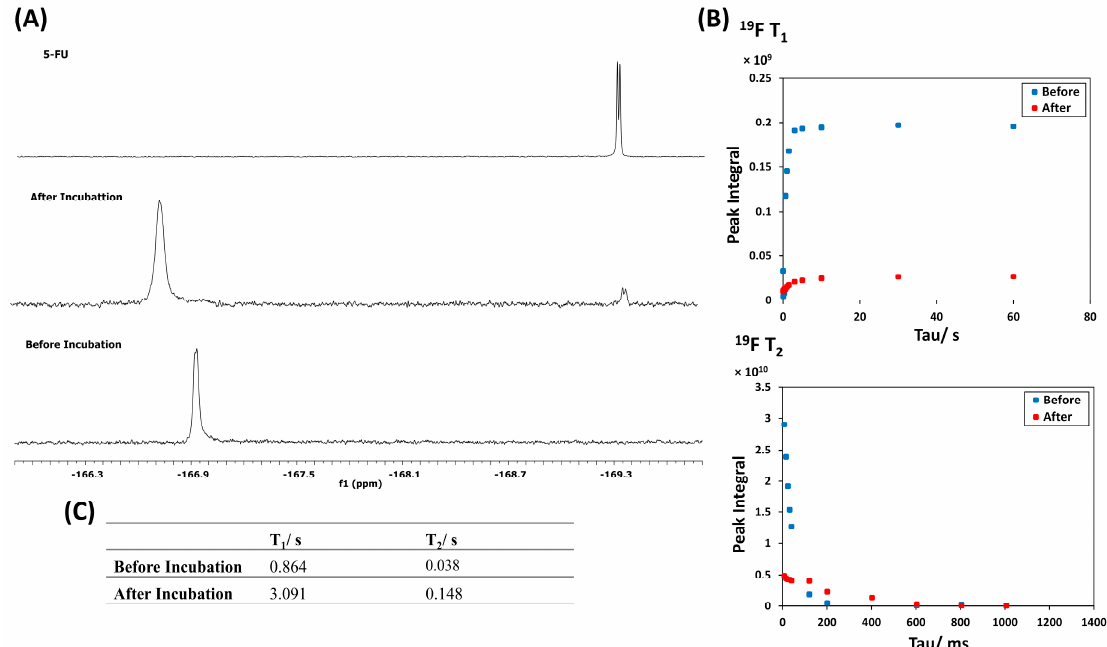
Figure 5. ( A ) 19 F NMR spectrum of 5-FU polymer conjugate in PBS/D 2 O (9:1) containing 3 mM MgCl 2 before and after the incubation with the S9 fraction from the liver. ( B ) 19 F T 1 and T 2 relaxation time curves of the polymer and the released 5-FU. ( C ) List of 19 F T 1 and T 2 relaxation times of the polymer and the released 5-FU.